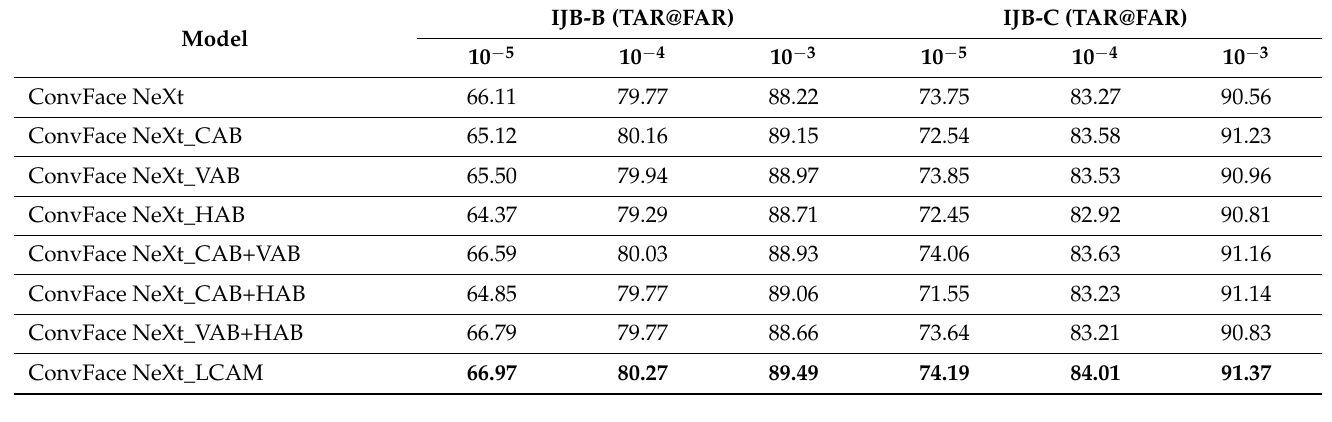
Table 4. Verification accuracy on different combination of branches for IJB-B and IJB-C datasets. (Bold Table 4. Veri fi cation accuracy on di ff erent combination of branches for IJB-B and IJB-C datasets. values are the highest obtained values by the methods). (Bold values are the highest obtained values by the methods.)